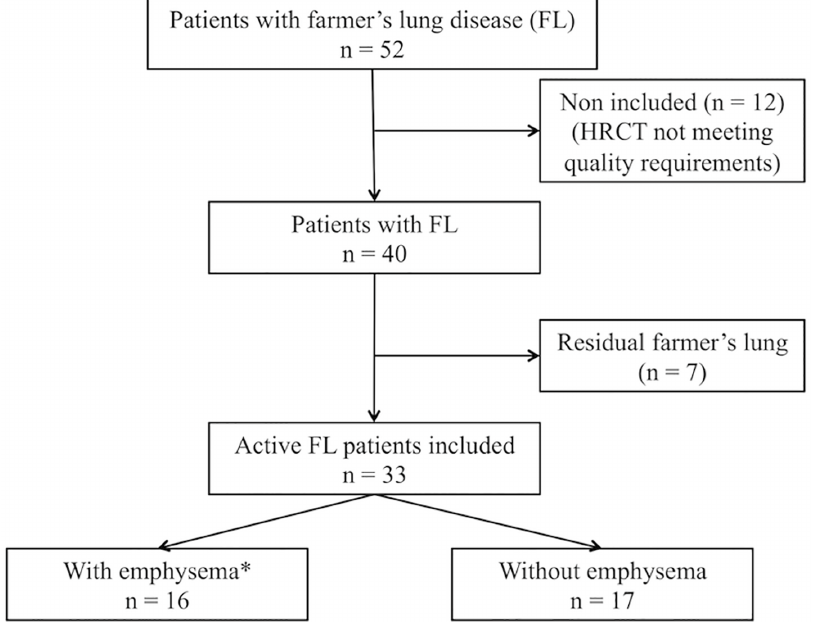
Fig 1. Flow chart of patients included in the study. * bilateralemphysema in at least three lobes.